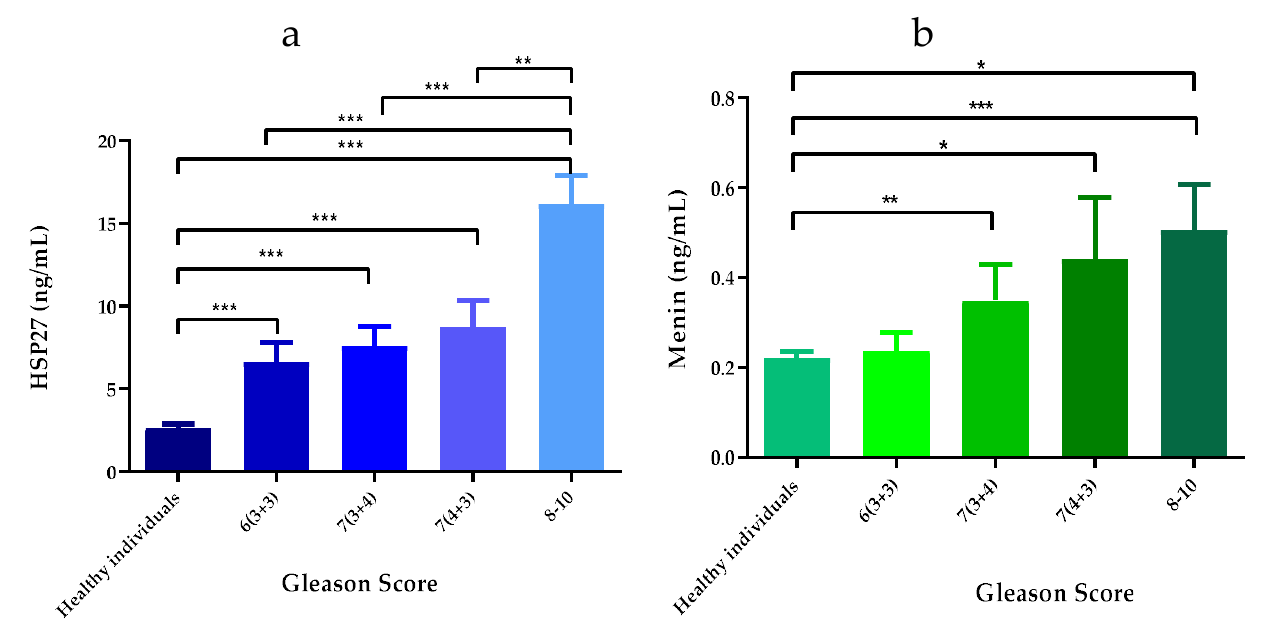
Figure 1. Serum HSP27 and Menin concentrations. ( a ) HSP27 expression in PCa patients according to the Gleason Score; ( b ) Menin expression in PCa patients according to the Gleason Score. Significant difference between different patients’ groups: * p -value ≤ 0.05, ** p -value ≤ 0.01, *** p -value ≤